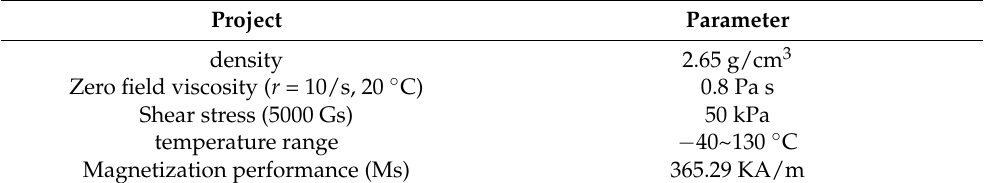
Table 1. Related characteristic parameters of MRF-J25T magnetorheological fluid.